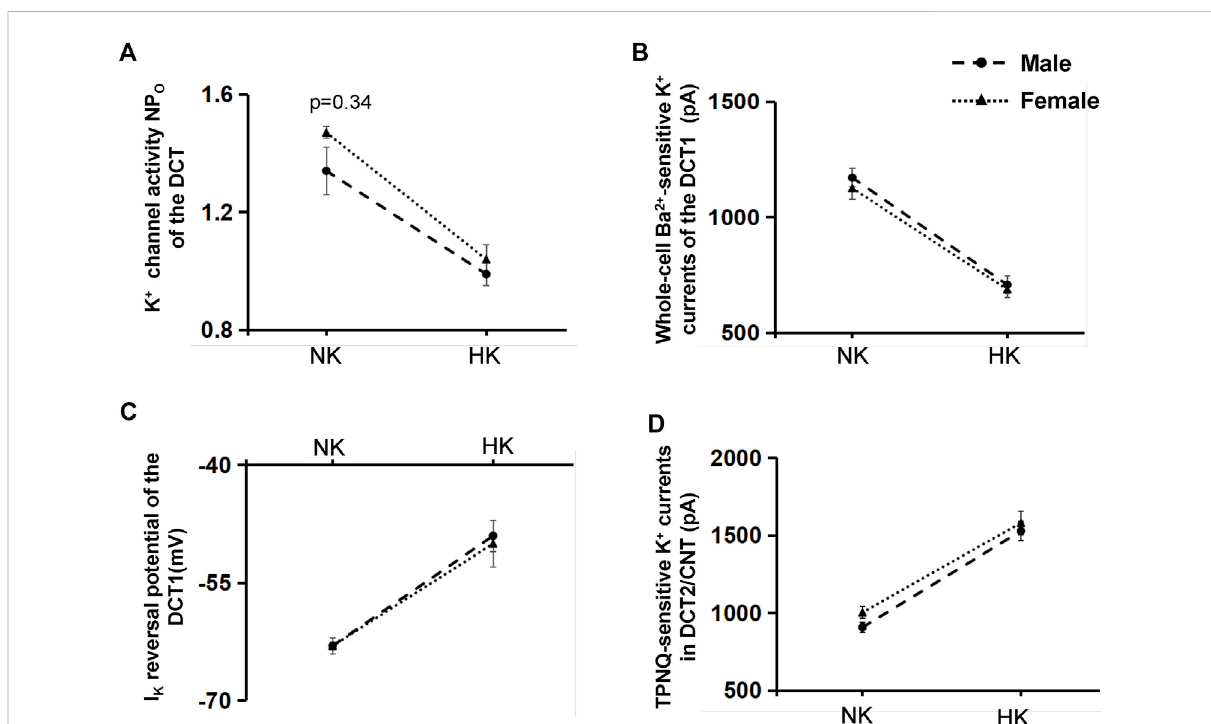
FIGURE 9 TheeffectofHKonKir4.1/Kir5.1andROMKofDCTisnotaffectedbygender. (A) ALinegraphssummarizestheexperimentsinwhichNP o ofthe 40 pSK + channel(Kir4.1/Kir5.1)wasmeasuredintheDCTofmale(circle)andfemale(triangle)miceonNKorHK(5%KCland5%K-citrate) for 7 days. (B) A line graphs summarizes the experiments in which whole-cell Kir4.1/Kir5.1-mediated K + currents at − 60 mV were measured in the DCT of male (circle) and female (triangle) mice on NK or HK (5% KCl and 5% K-citrate) for 7 days. (C) A line graphs summarizes the experiments in which I K reversal potential was measured in the DCT of male (circle) and female (triangle) mice on NK or HK (5% KCl and 5% K-citrate) for 7 days. (D) A